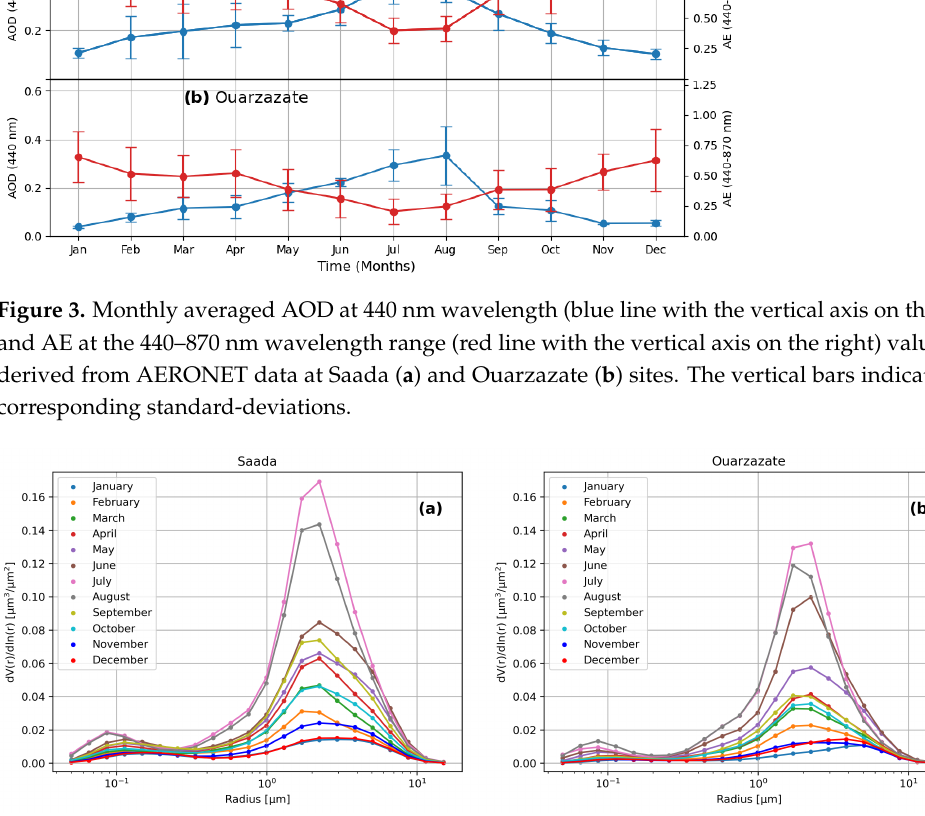
Figure 4. Monthly averaged volume size distributions (VSD) obtained from sun-photometer measure- ment at Saada ( a ) and Ouarzazate ( b ) AERONET sites with level 2.0 data during the study periods (2004–2019 and 2012–2015),